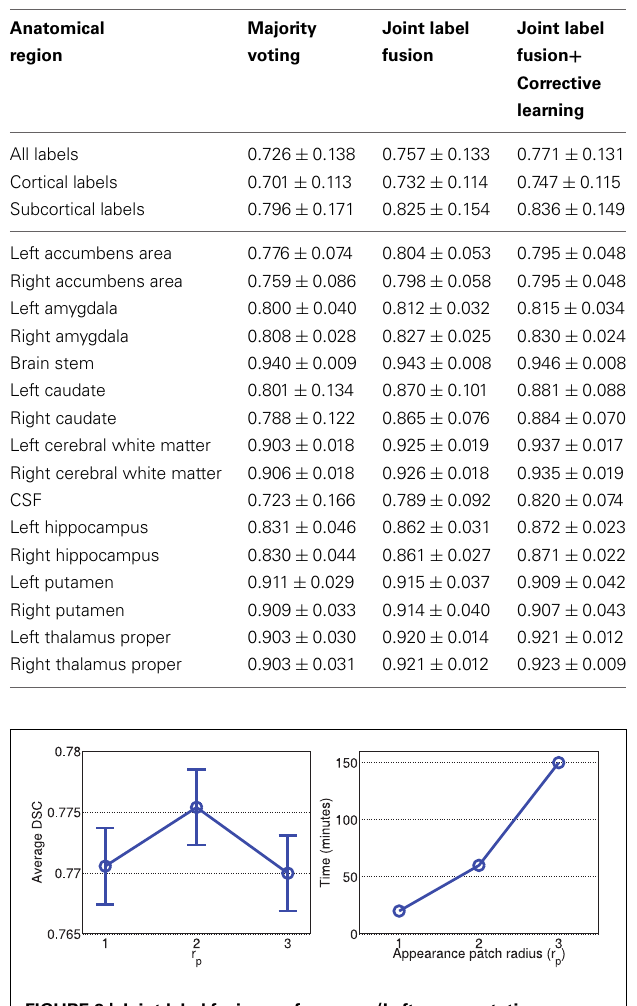
Table 1 | Segmentation performance in Dice Similarity Coefficient (cid:2) 2 | A ∩ B |